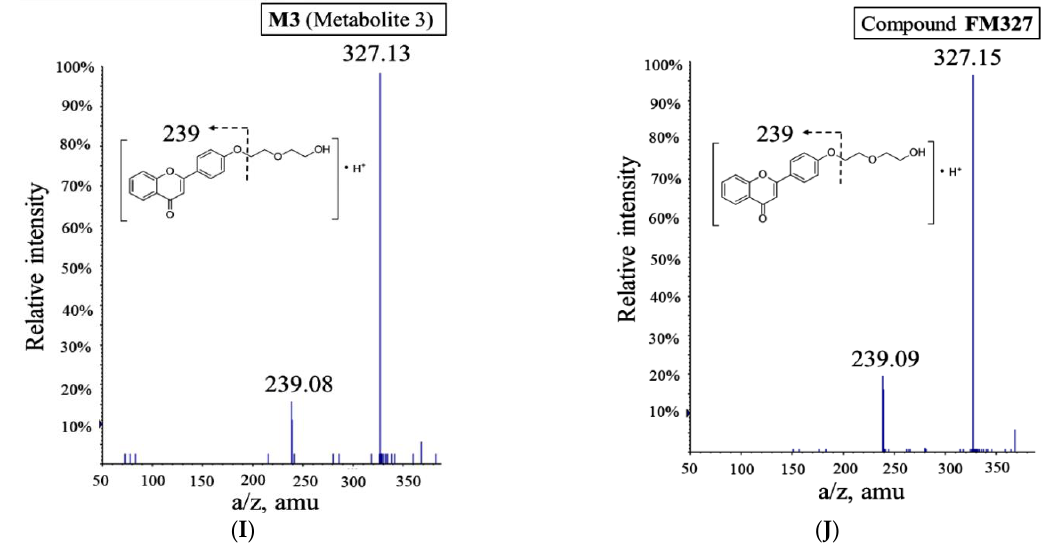
Figure 2. Identification of metabolites of FD18 . LC/QTOF-MS extracted ion chromatograms of FD18 incubated with liver microsomes. Human liver microsomes (HLM) or rat liver microsomes (RLM) were incubated with FD18 with or without NADPH for 30 min at 37 °C. Metabolite mixture was separated by LC/QTOF-MS. Three metabolites were found after incubation. FD18 (724 m / z ); M1 = metabolite 1 (634 m / z ); M2 = metabolite 2 (416 m / z ); M3 = metabolite 3 (327 m / z ). ( A ) FD18 and HLM (+ NADPH). ( B ) FD18 and HLM ( − NADPH). ( C ) FD18 and RLM (+ NADPH). ( D ) FD18 and RLM ( − NDPH). Metabolites M1, M2 and M3 were subjected to LC/QTOF-MSMS analysis and their mass spectrums were shown here. According to the mass spectrum, the respective structure of M1 , M2 and M3 were predicted and synthesized. Then, the pure synthetic compounds were analyzed by the MS. ( E ) mass spectrum of M1 . ( F ) mass spectrum of synthetic compound 14a which has been reported in 2012 [23]. ( G ) mass spectrum of M2 . ( H ) mass spectrum of synthetic compound FM04 which has been reported in 2021 (Reprinted/adapted with permission from ref. [25] copyright © 2021 by American Society for Microbiology). ( I ) mass spectrum of M3 . ( J ) mass spectrum of synthetic compound FM327